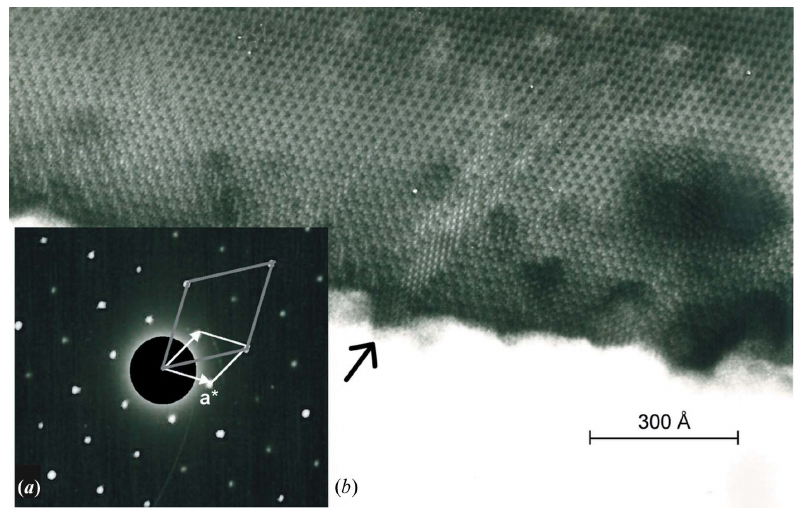
Figure 2 ( a ) SAED patterns of kaliophilite from Pollena (Vesuvius, Naples, Italy), with zone axis [001]. The reciprocal cell of kaliophilite is sketched in white, whereas the reciprocal vectors corresponding to the 15.6 A˚ periodicity are represented in gray. In ( b ) the corresponding HRTEM image is shown. The arrow indicates a slab with apparent 15.6 A˚ periodicity within the kaliophilite crystal. Other defects are also visible [modified from Bonaccorsi (1988)].